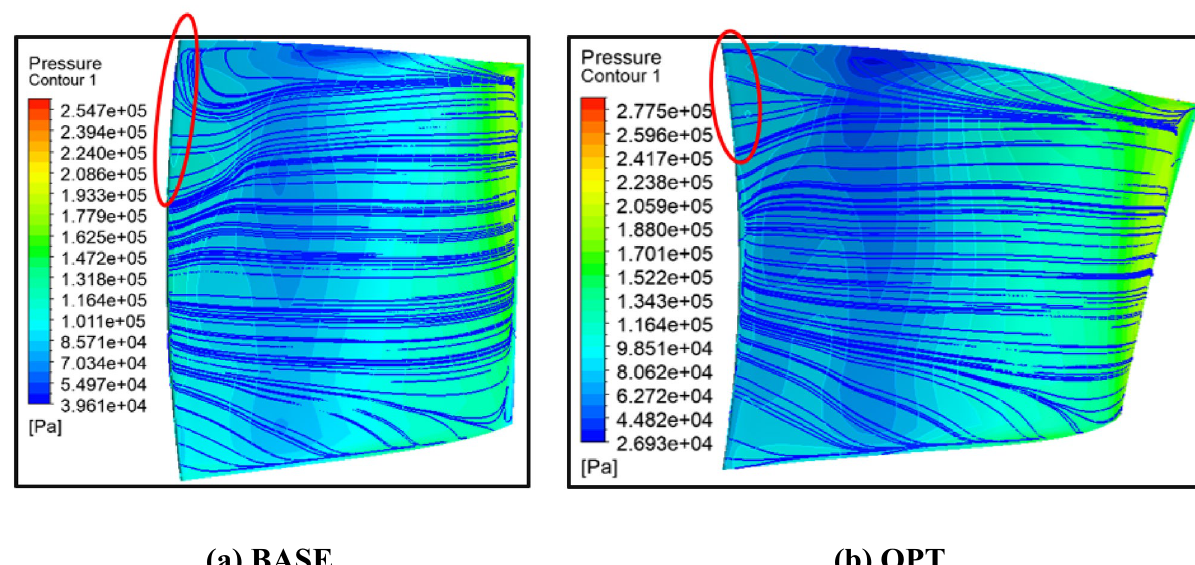
Fig. 14 Suction surface streamline and pressure contour on the rotor